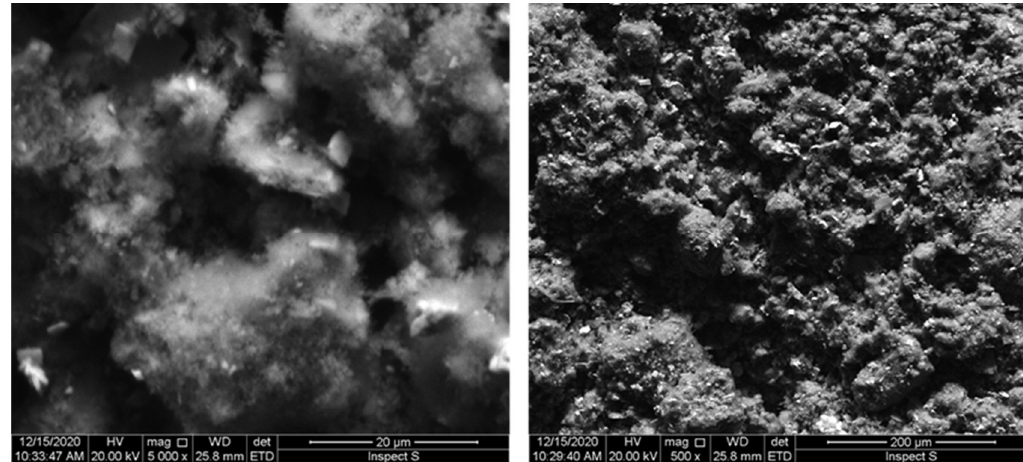
Figure 4. SEM images of WTBS: left image (surface at 5000× magnification); right image (surface at 500× magnification).